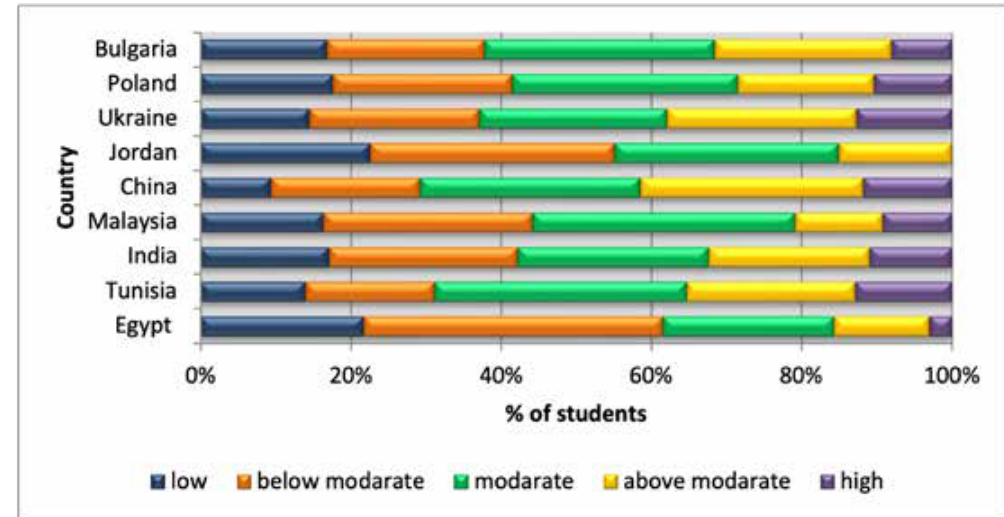
Figure 6. Distribution by levels of development of students’